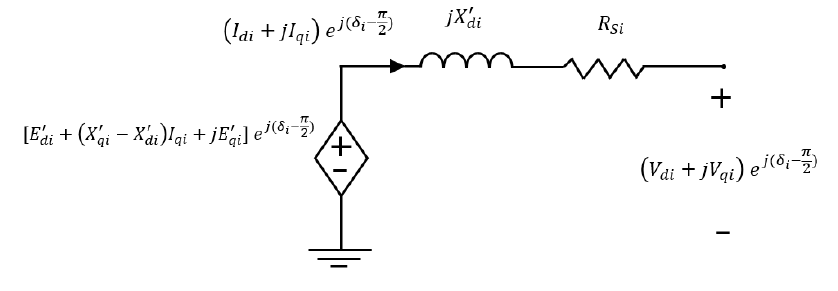
Figure 1. Model of the two axes used in the